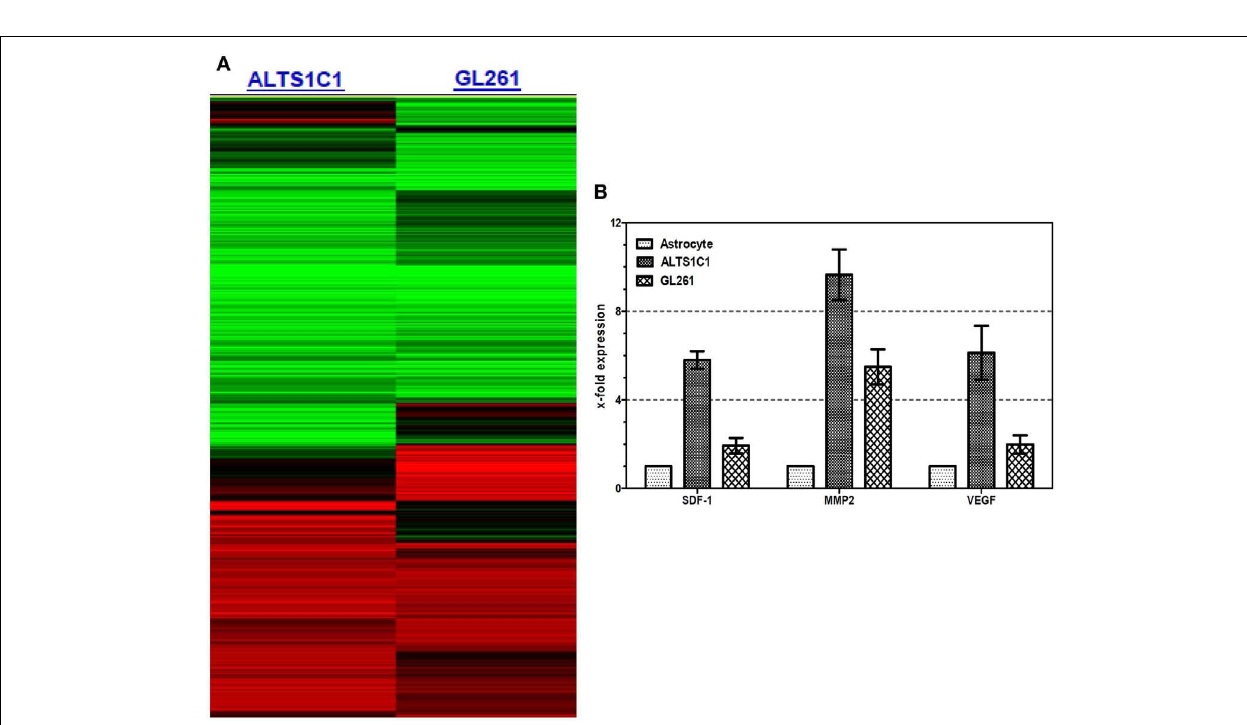
(A,B) or in the brain (i.c.) (C,D) . Green: anti-PIMO stain for hypoxic region; red: anti-CD68 antibody forTAMs. Merged images: the colocalization of hypoxia andTAMs. Scale bar = 100 µ m.